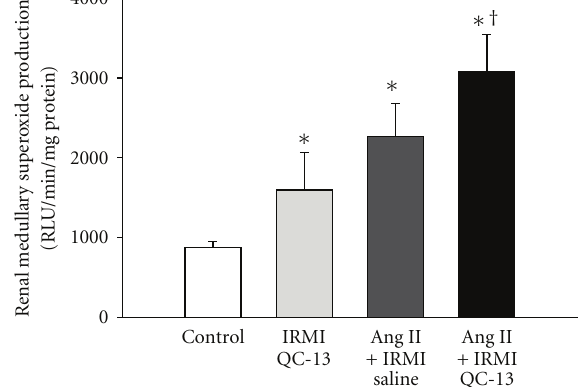
Figure 3: Renal medullary superoxide production in control, IRMI QC-13, Ang II + IRMI saline, and Ang II + IRMI QC-13-treated mice, n = 6/group. Renal medullary superoxide production was measured using the lucigenin technique as described in Section 2. ∗ P < 0 . 05 as compared to value in control mice. † P < 0 . 05 as compared to Ang II-treated